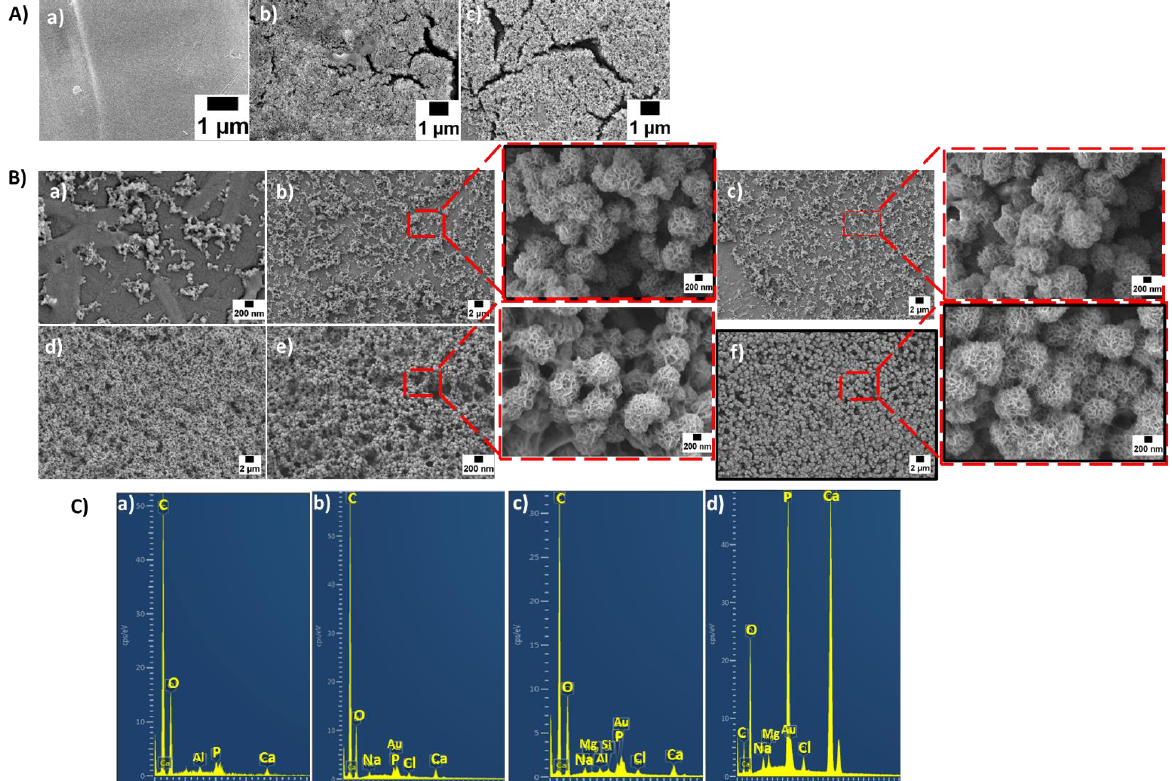
Figure 6. SEM images of uncoated scaffolds after immersion in SBF for 28 days ( A ): PCL ( a ), PCL/13- 93 ( b ), PCL/13-93B3 ( c ). Coated scaffolds after immersion in SBF for 7 days at different magnifica- tions ( B ): PCL Coat 1 ( a ), PCL/13-93 Coat 1 ( b ), PCL/13-93B3 Coat 1 ( c ), PCL Coat 2 ( d ), PCL/13-93 Coat 2 ( e ), PCL/13-93B3 Coat 2 ( f ). EDX spectra of uncoated and coated scaffolds ( C ): PCL/13-93